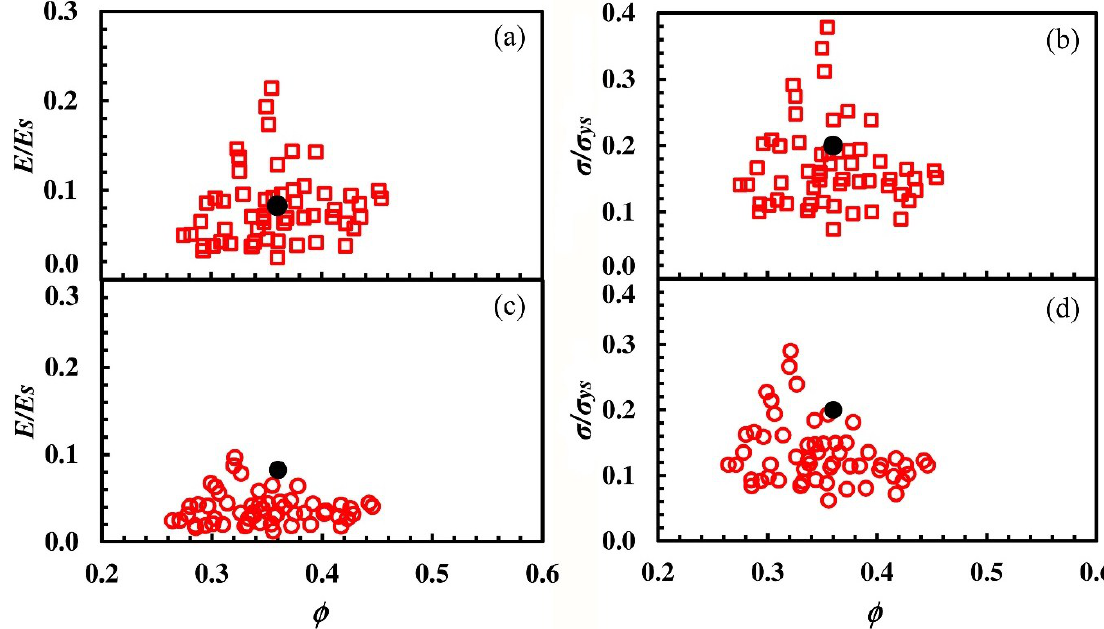
Figure 11. The relative Young’s modulus E / E s and the relative yield strength σ/σ ys as a function of relative density  . Data refer to the cases of ligaments with square, ( a ) and ( b ), and circular, ( c ) and ( d ), cross-sections, respectively. Model predictions (open symbols) are derived from the calculation of the relative elastic modulus and relative yield strength for different ligaments with their characteristic lengths measured by image analysis. The full symbol is the experimental value of the considered nanoporous metal